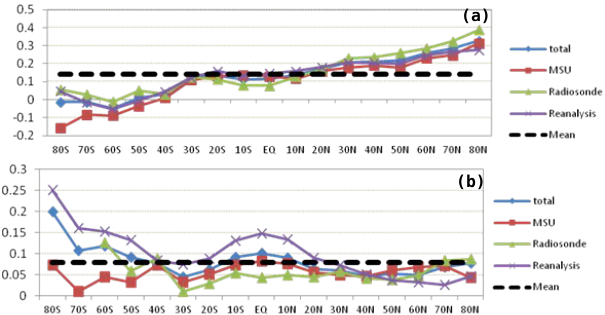
Fig.4 Similar to the Fig. 2 except for the TroposphericTemperature (T CH2 ) Trends. Fig. 4. Similar to the Fig. 2 except for the tropospheric temperature ( T CH2 )